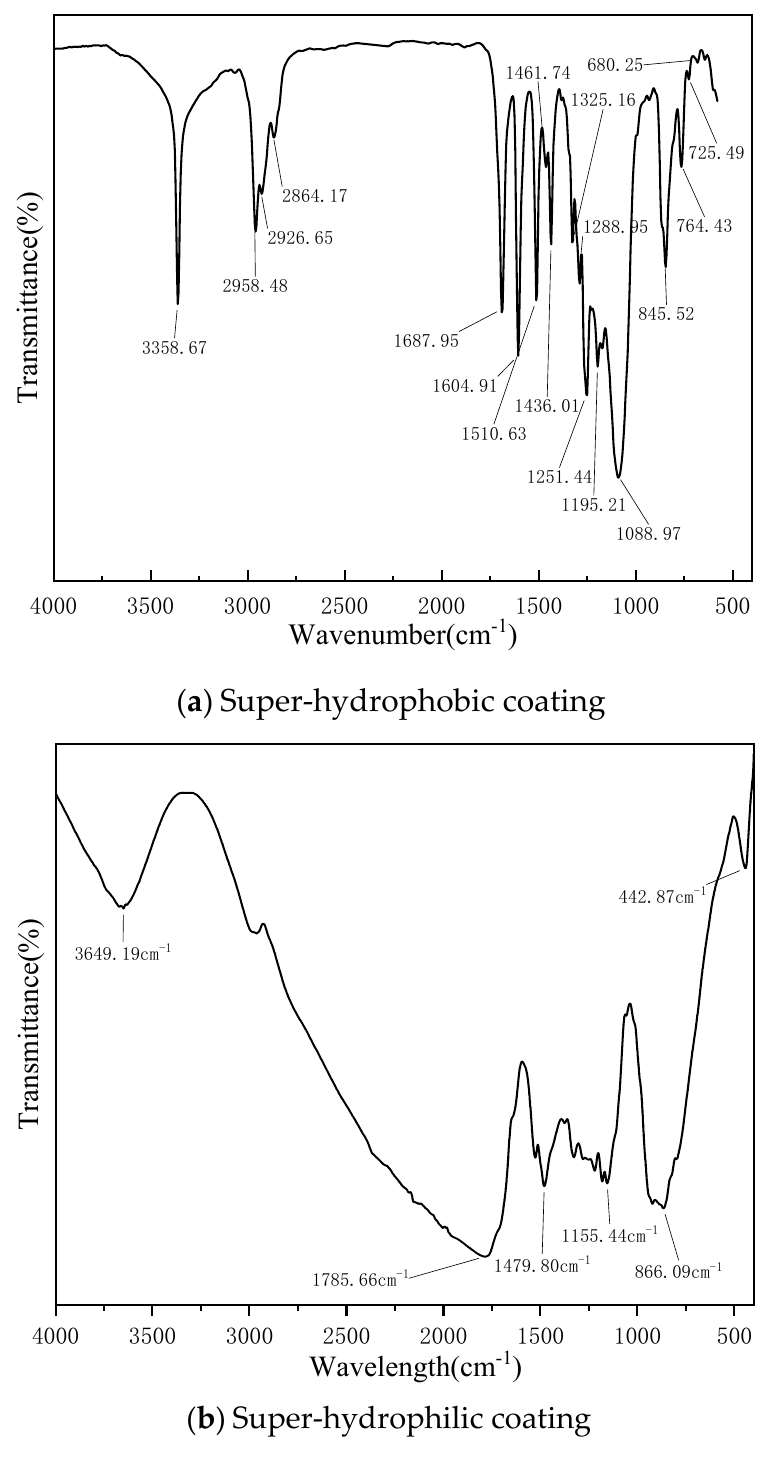
Figure 4. FTIR spectra of super-hydrophobic and super-hydrophilic coating.